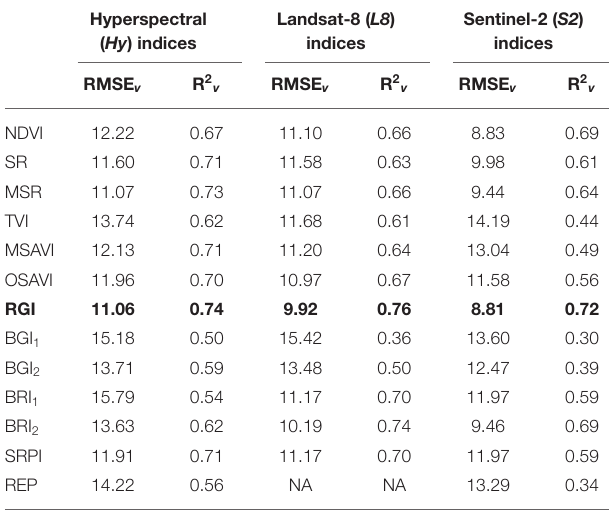
TABLE 4 | Validation statistics (RMSE v and R 2 v ) of simple linear regression models of Hyperspectral ( Hy ) indices, and synthesized Landsat-8 ( L8 ) and Sentinel-2 ( S2 ) indices for canopy height of finger millet.